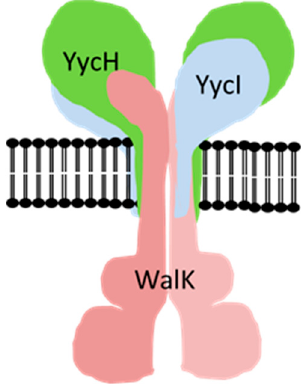
Figure 1. Schematic drawing of the complex formed by the WalK dimer and the accessory proteins YycH and YycI in the cytoplasmic membrane as proposed by Fukushima et al. (2008) [23] for B. subtilis .